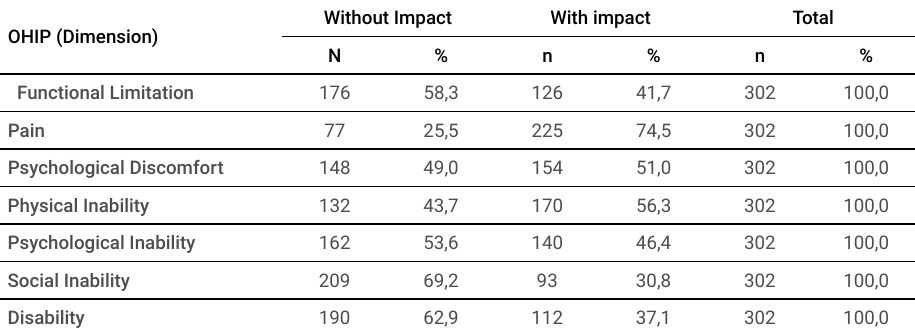
Table 4. Prevalence of impact of oral changes in quality of life per OHIP-14 domain among individuals with DM2 OHIP